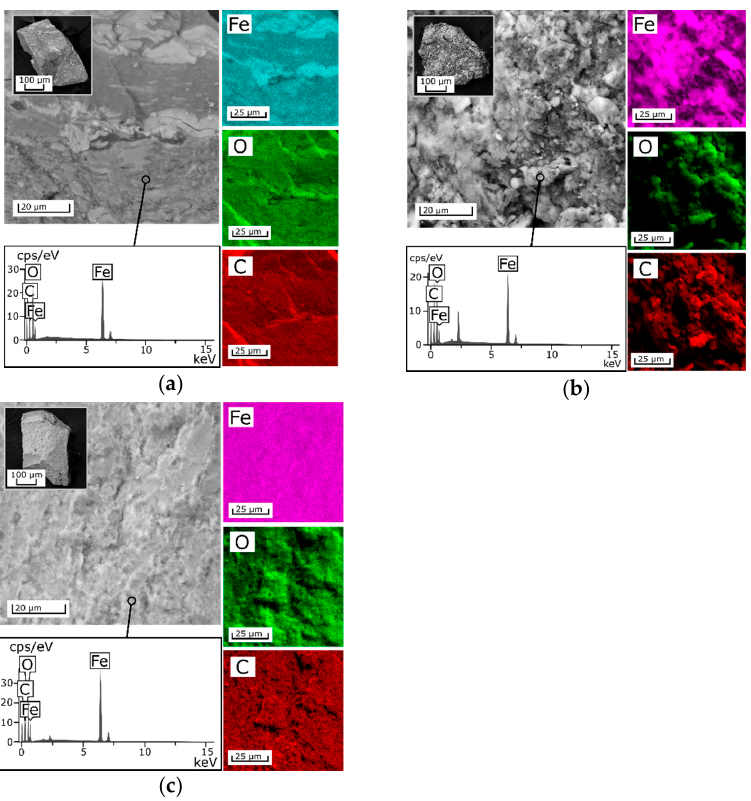
Figure 1. Scanning electron microscopy–energy dispersive X-ray spectroscopy (SEM–EDX) analysis of composite sorbents. Sorbents ( a ) 1A; ( b ) 2M; and ( c )